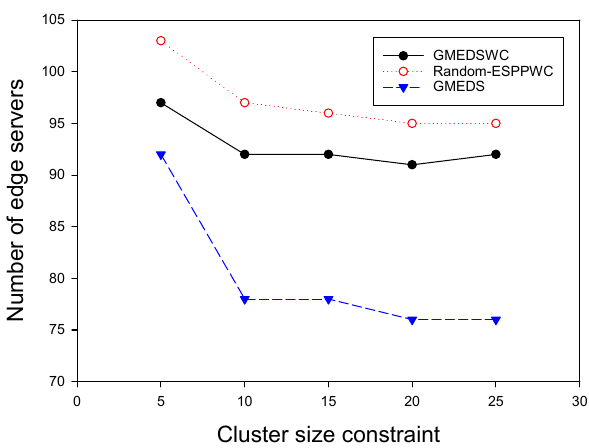
Figure 13. The impact of cluster size on the number of edge